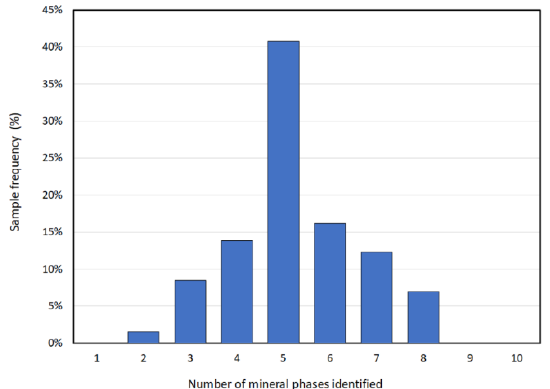
Figure 1. Histogram showing the number of different mineral phases found in individual